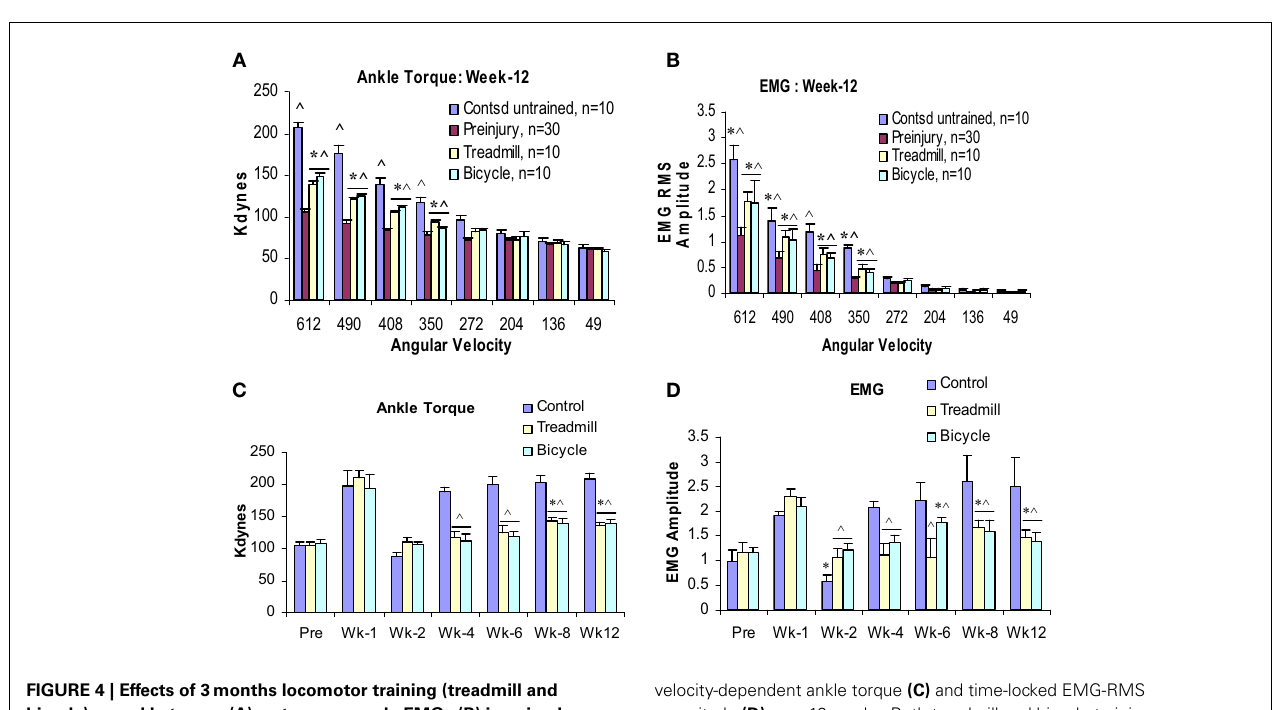
FIGURE 4 | Effects of 3months locomotor training (treadmill and bicycle) on ankle torque (A), extensor muscle EMGs (B) in animals with midthoracic contusion injury. Three-month locomotor training showed significant reduction of spasticity (ankle torque and EMGs) in both training groups (49% reduction).The time course of